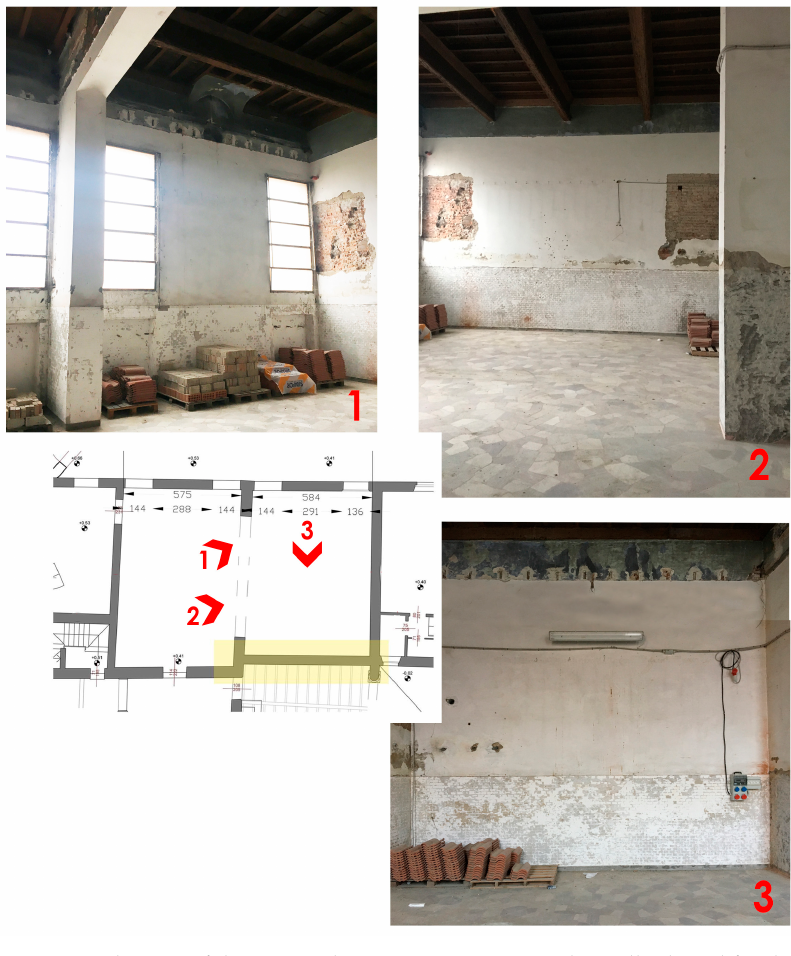
Figure 2. Internal views of the room. The picture 3 represents the wall selected for the tests.